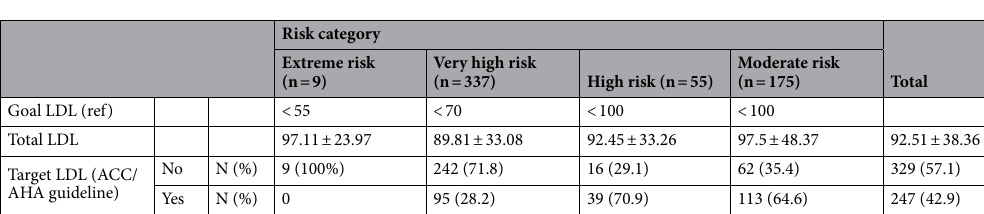
Table 3. Proportion of patients attaining targets for low density lipoprotein (LDL) according to American Association of Clinical Endocrinologists (AACE) guideline. ACC/AHA The American College of Cardiology/ American Heart